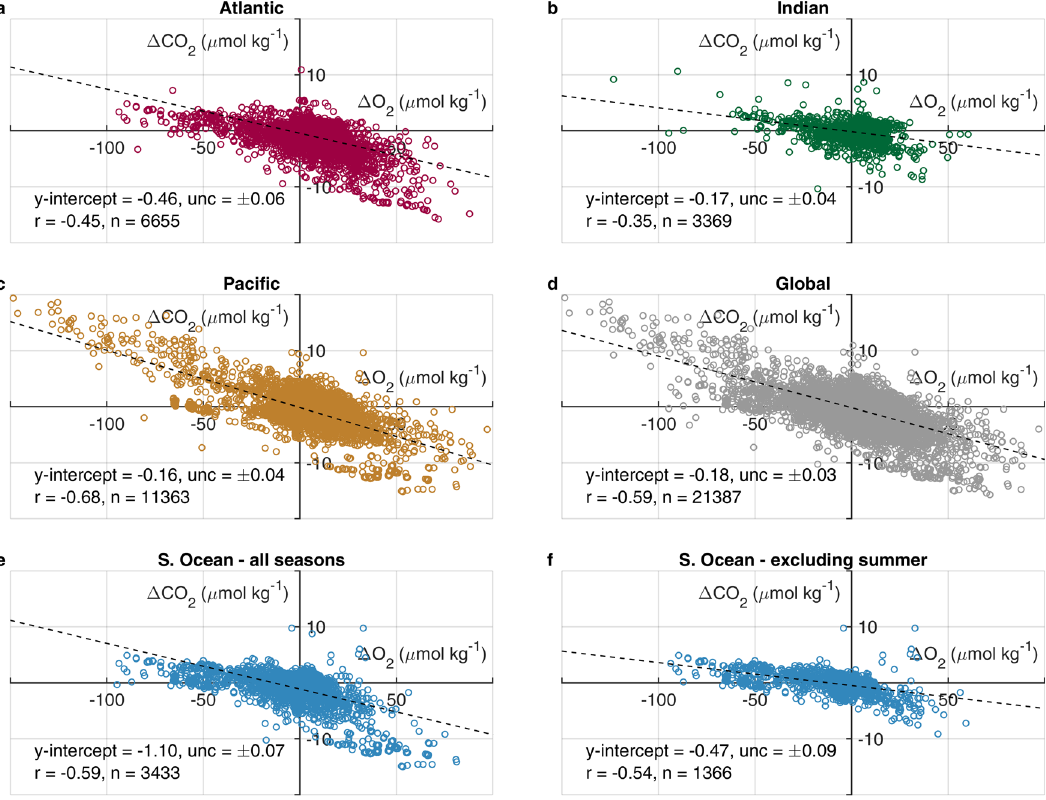
Fig. 4 Relationships between Δ CO 2 and Δ O 2 in the global ocean basins. a Atlantic Ocean, b Indian Ocean, c Paci fi c Ocean, d global oceans, e Southern Ocean with all seasons included, and f Southern Ocean with summer excluded. The black dashed lines are the least-squares best- fi t lines of data; unc denotes the uncertainty in y-intercept with 95% con fi dence level; r is the associated Pearson correlation coef fi cient; n is the number of data points.